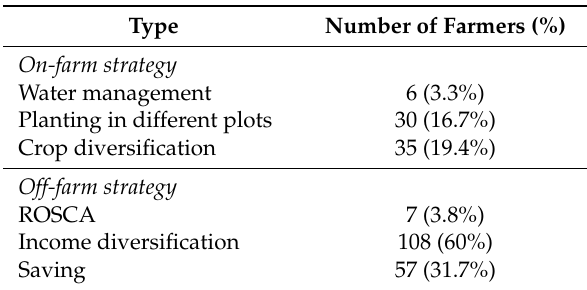
Table 4. Ex ante coping strategies adopted by